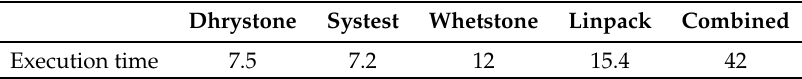
Table 3. Execution time per injection for each benchmark (in seconds).